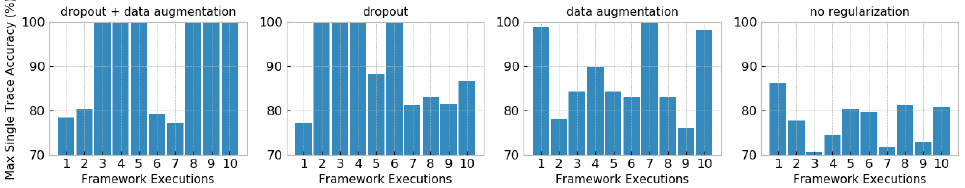
Figure 19: Random CNN hyperparameters: maximum single trace accuracy on the cswap- arith dataset for ten different framework executions and for random CNN